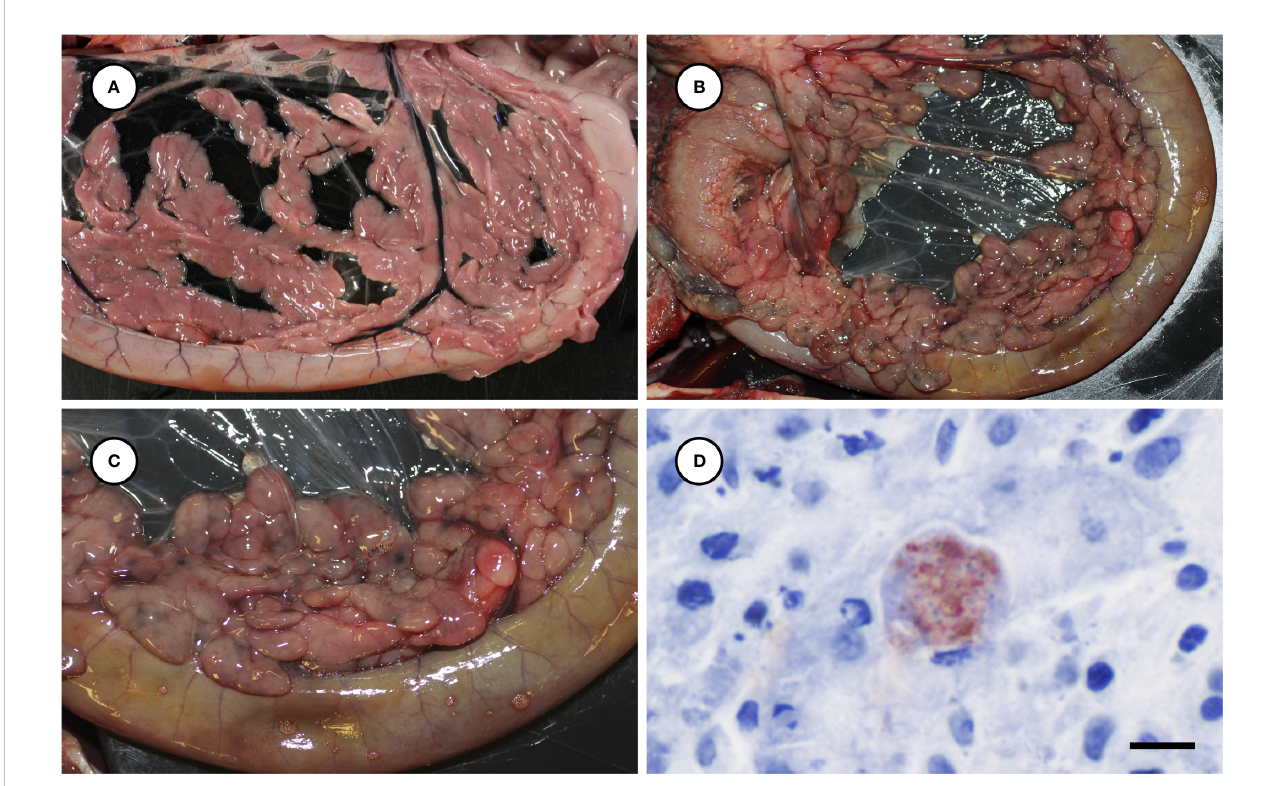
FIGURE 3 Normal pancreas from an unaffected sea otter (A) , compared with low (B) and higher magni fi cation (C) views of swollen, edematous, red-black discolored pancreas from a sea otter with protozoal pancreatitis. Immunohistochemical stain of in fl amed pancreas demonstrating strong positive immunostaining of intralesional T. gondii parasites ( D : Bar = 10